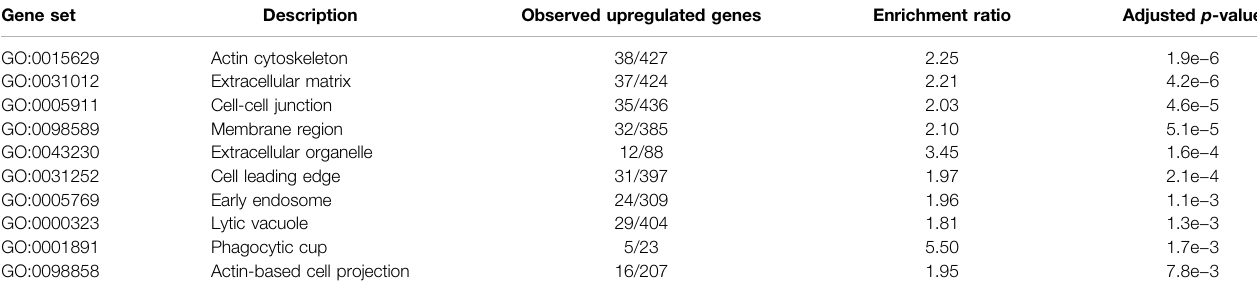
TABLE 1 | Gene Ontology categories affected by Runx1 overexpression in GSE19836 dataset. Gene set